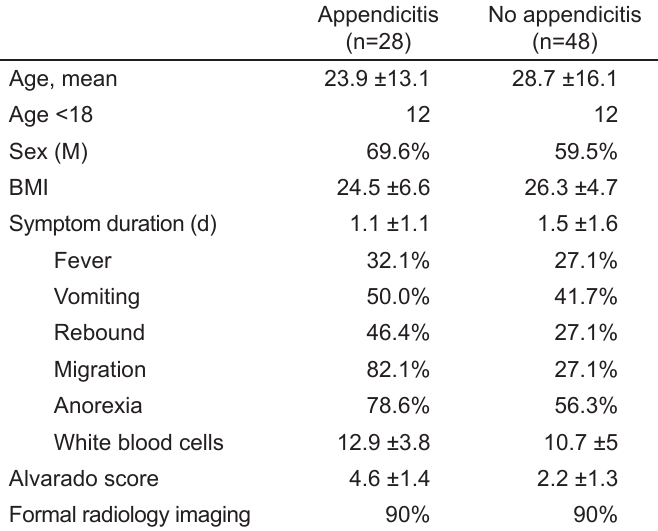
Table 1. Patient characteristics with moderate to high pre-test probability.